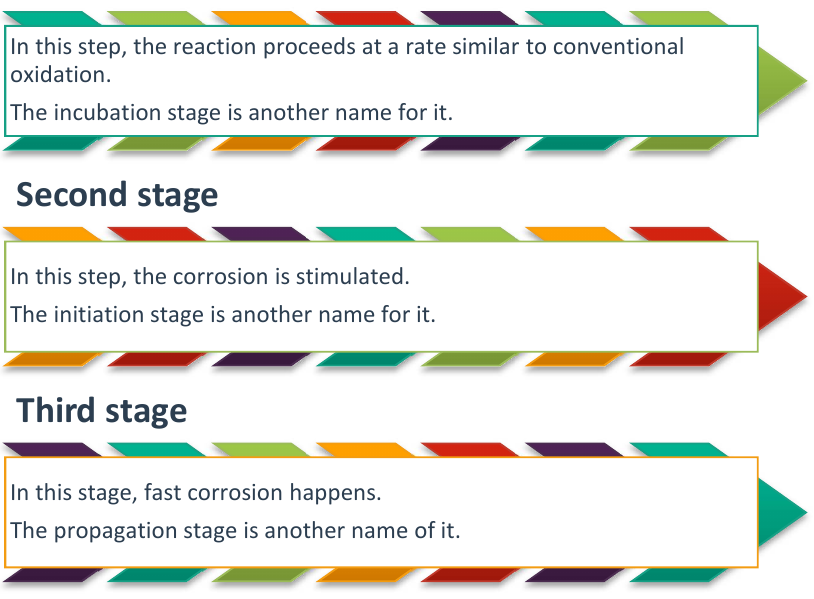
Figure 20. Mechanism of hot corrosion and stages.